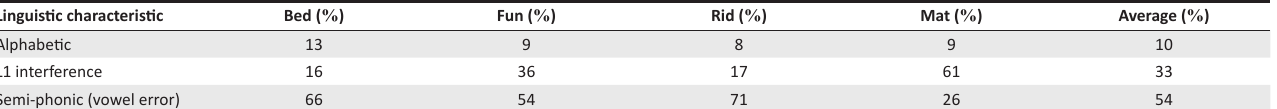
TABLE 2: Spelling errors by linguistic